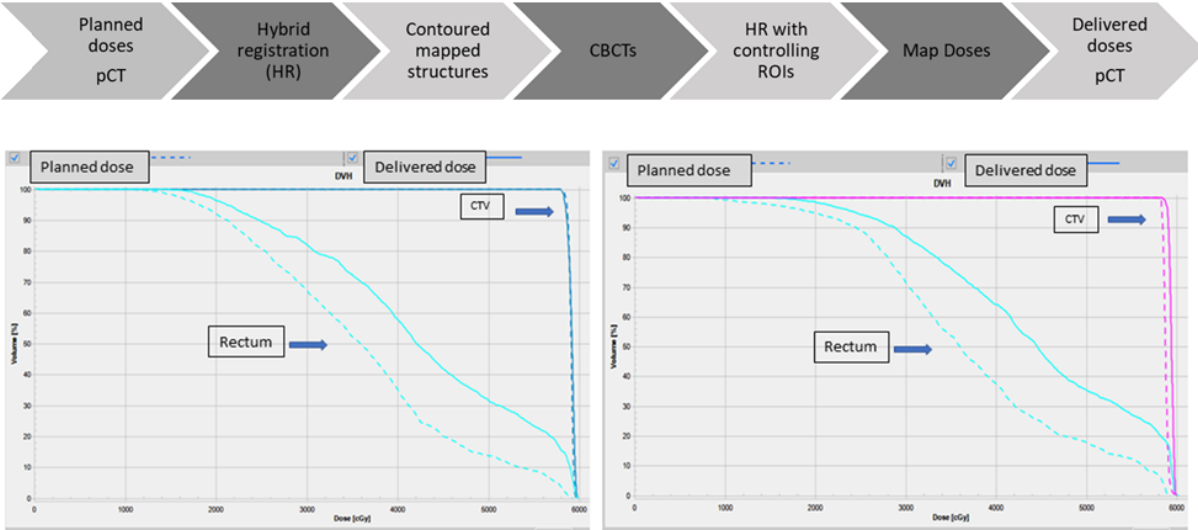
Figure 1. Deformable image registration ART workflow and planned and delivered dose volume histograms comparison. pCT: planning CT; ART: adaptive radiotherapy; CBCT, cone-beam computed tomography; ROI: region of interest; CTV: clinical target volume.